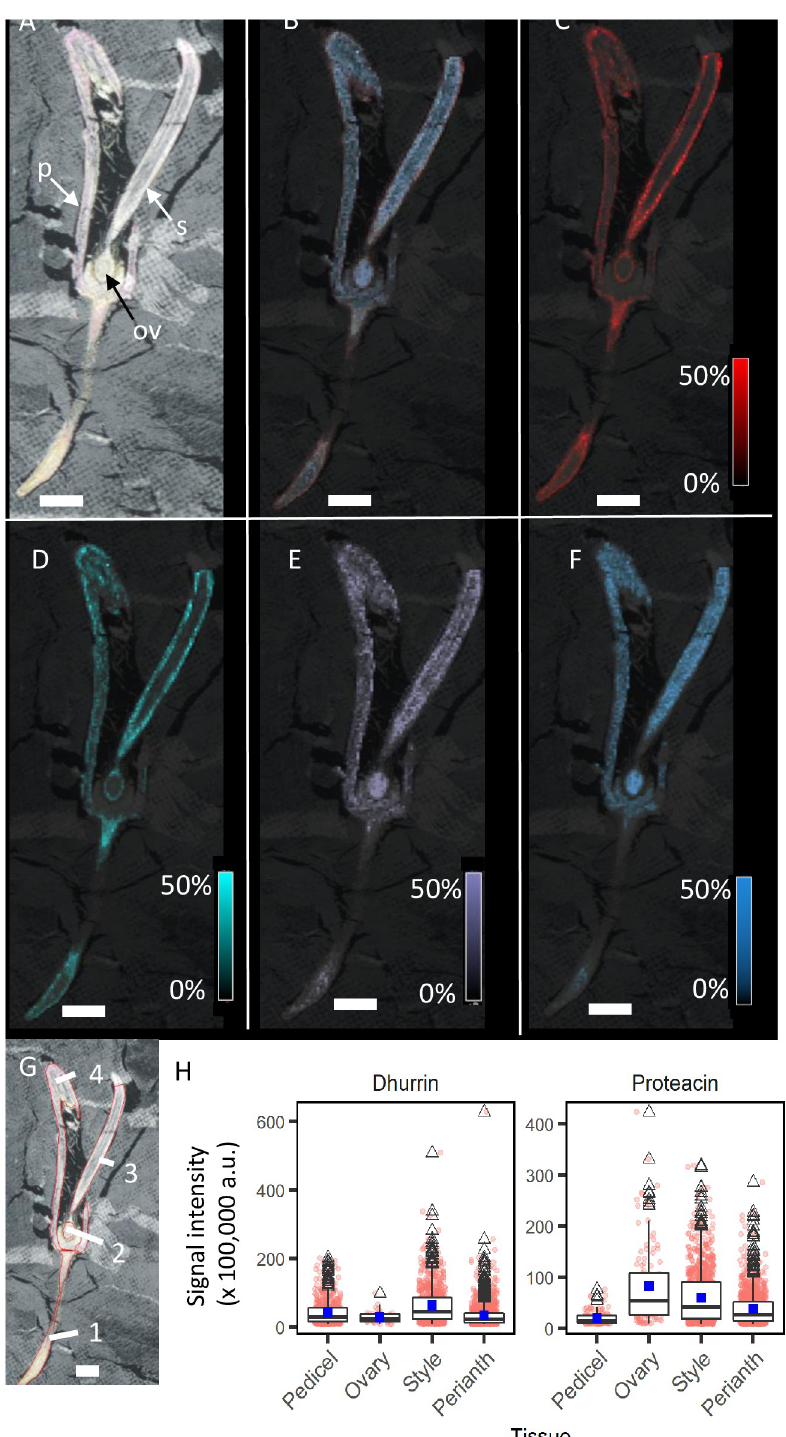
Fig 4. MALDI-MS images of longitudinal section of Macadamia tetraphylla floret at the partially open stage. (A) Optical image of floret longitudinal-section (35 μ m thick), where p is perianth, s–style and ov–ovules. (B) Merged positive ion MALDI-MS image showing dhurrin and proteacin, (C) dhurrin [M + Na] + ( m/z 334.0896, Δ m 0.3 mDa), (D) dhurrin [M + K] + ( m/z 350.0635, Δ m 0.6 mDa), (E) proteacin [M + Na] + ( m/z 496.1421, Δ m 0.8 mDa) and (F) proteacin [M + K] + ( m/z 512.1164, Δ m 0.2 mDa). All MALDI-MS images were obtained using 50 × 50 μ m array. White scale bars indicate 1 mm. Coloured intensity scales represent 0–50% TIC normalised signal intensity. (G)